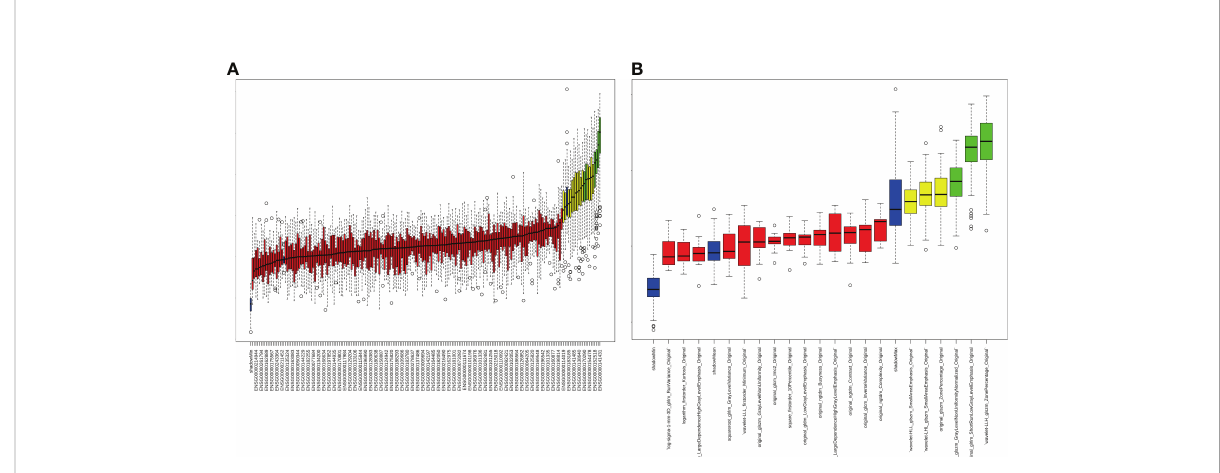
FIGURE 3 Strategy for feature selection using the Boruta method. (A) Genomics feature selection; (B) Radiomics feature